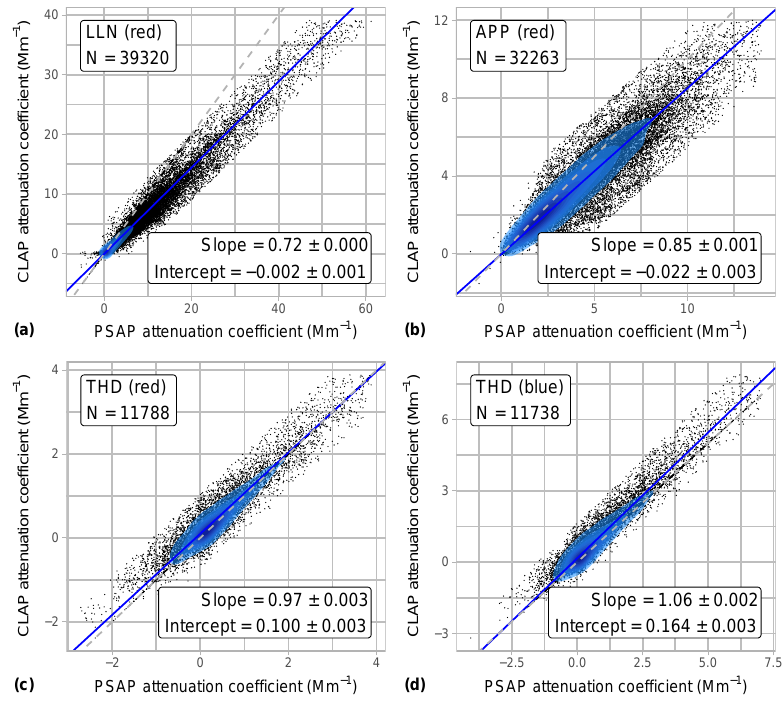
Figure 10. Comparison of attenuation coefficients measured with CLAP and PSAP at three stations (a) LLN, Mt. Lulin, Taiwan; (b) APP, Appalachian State University, Boone, NC, USA; (c) THD, Trinidad Head, CA, USA; (d) THD, blue wavelength. Results are for the red wavelength, except for (d) . The shaded areas contain 90% of the observations and the color shading distinguishes the deciles of the two- dimensional probability distribution function of the measurements. The orthogonal regression lines are shown in blue and the 1 : 1 line is gray and dashed. Slopes and intercepts of the orthogonal regression lines are included along with their uncertainties (95% confidence) and the number of hourly observations ( N ); the regression lines account for over 98% of the variance in each data